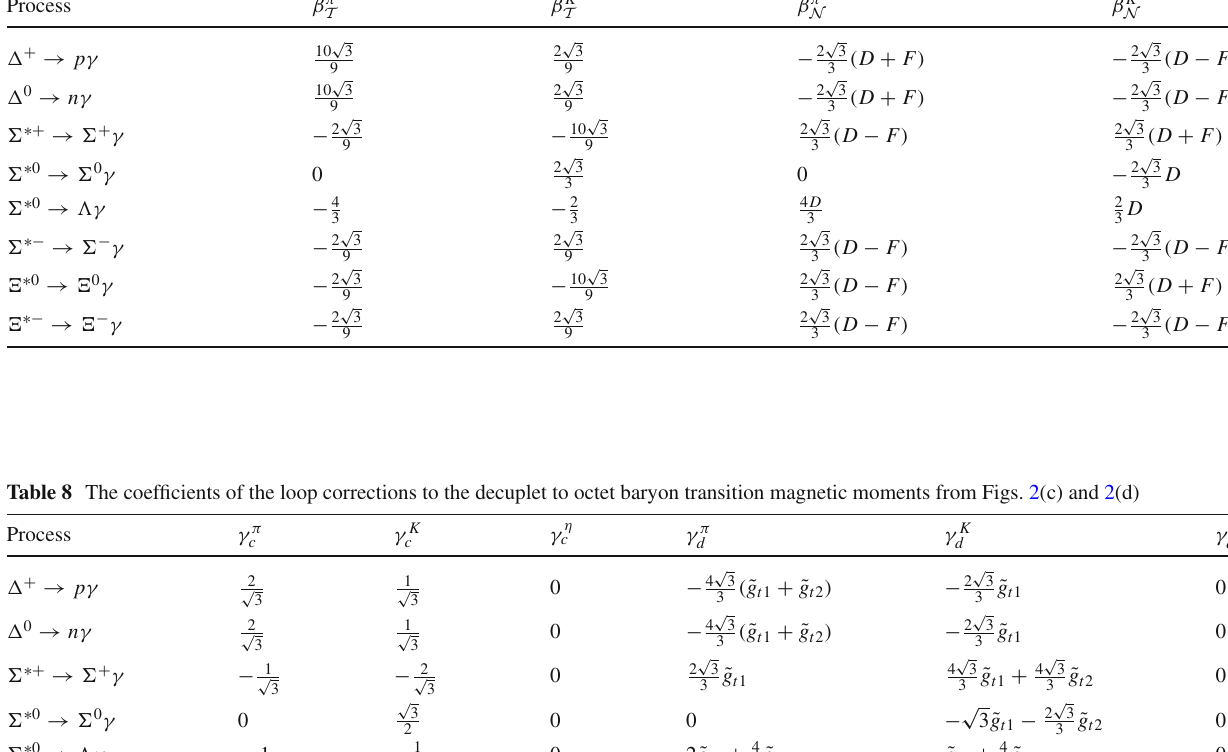
channel are zero. The reason is that the pion loop contributions from different intermediate states cancel each other. In other words, the pion loop contributions with the intermediate baryons (cid:13) ∗+ and (cid:13) ∗− , (cid:13) + and (cid:13) − cancel each other due to the exact SU(2) flavor symmetry